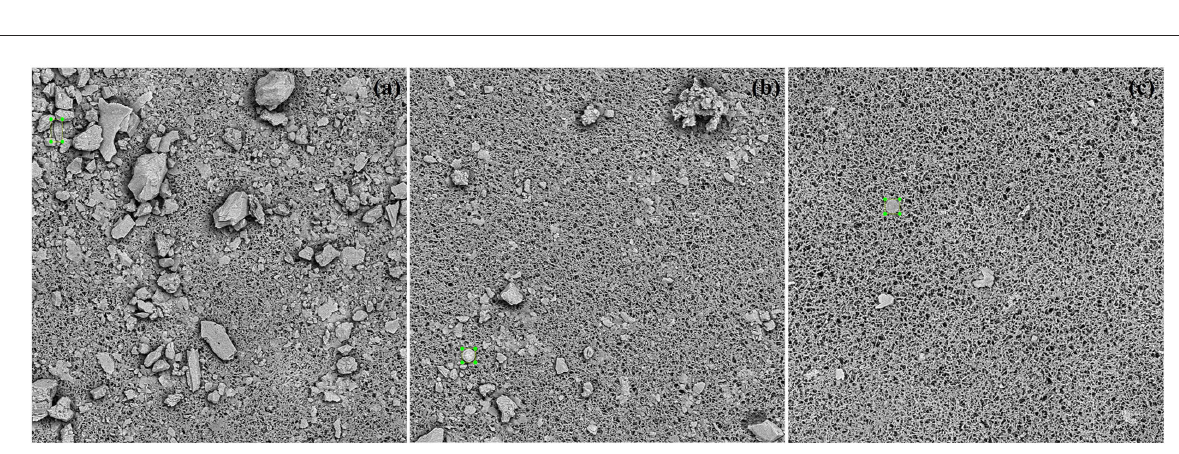
balance at the threshold 0.5, which is preferable for practice. In conclusion, the results in Tables 5, 6 indicate that the training in distinguishing the diatoms from the other sediments in